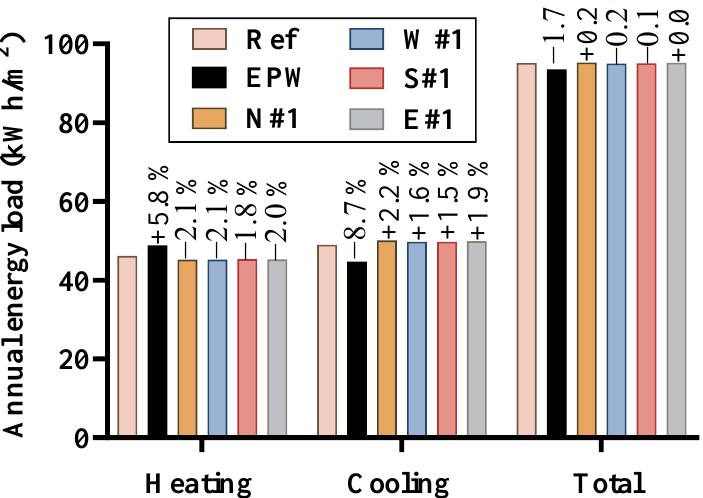
Figure 18. Energy loads for different orientations at the height of 3 m.